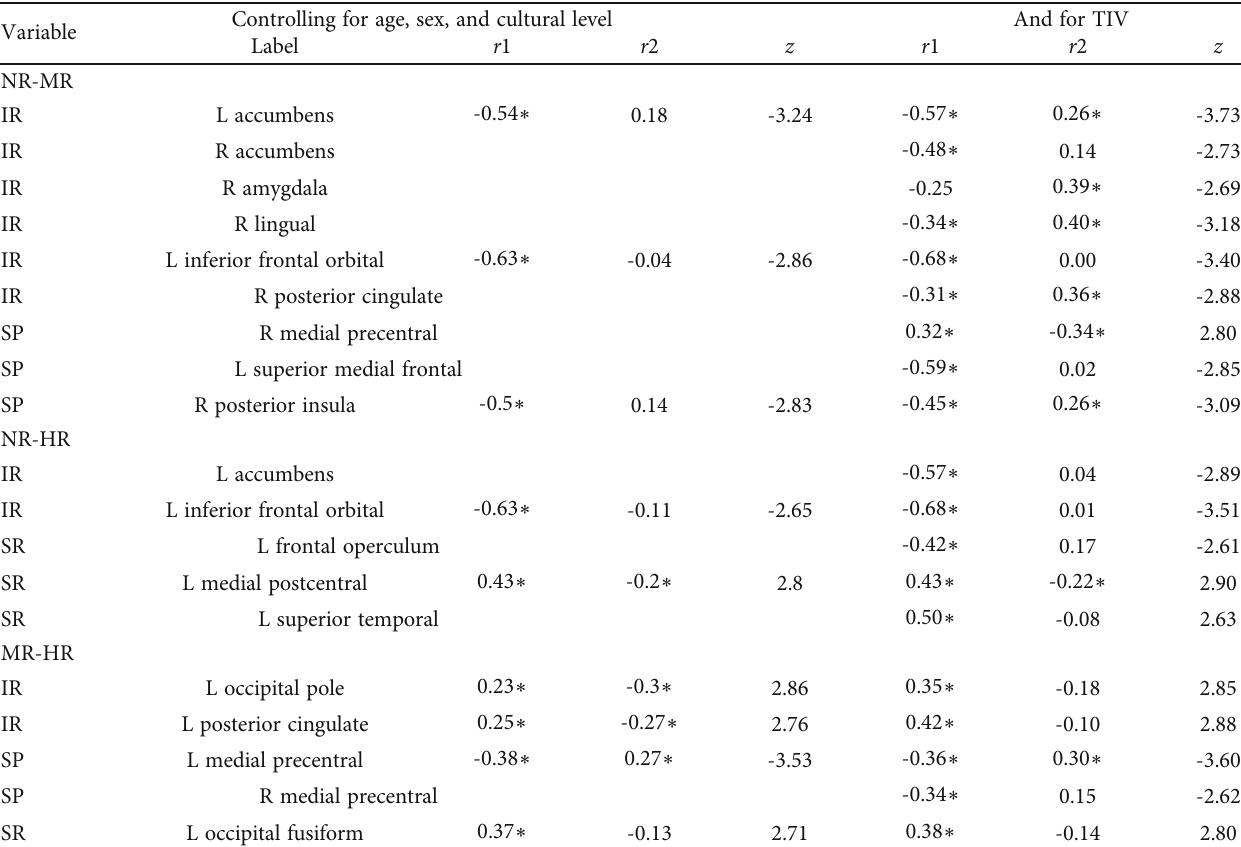
Table 3: Between-groups contrast of the correlations between SPSRQ and MCQ scores and gray matter volume, after controlling for age, sex, and cultural level (left) and also by total intracranial volume